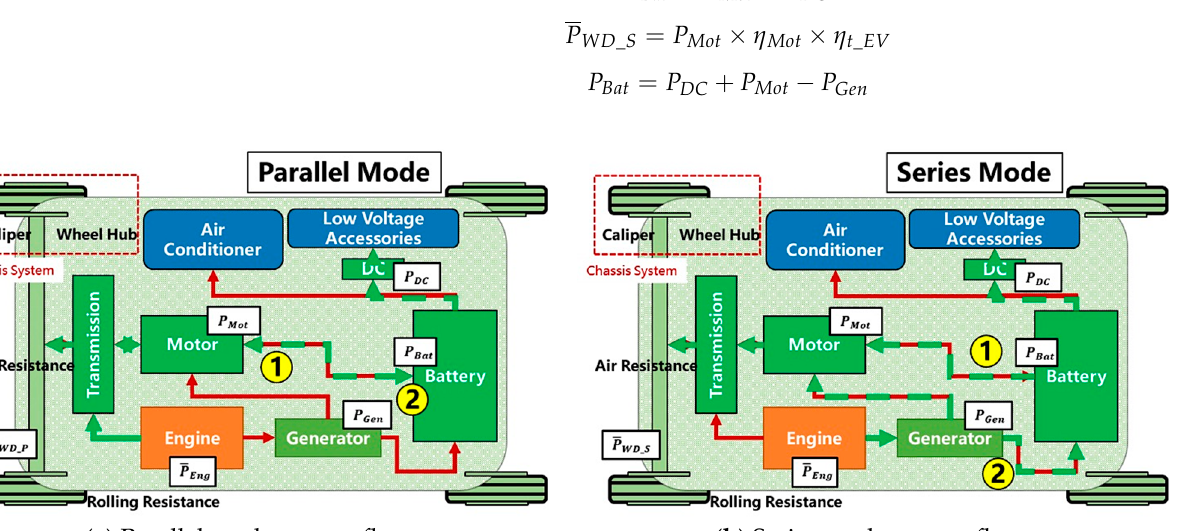
Figure 3. DMi HEV modes.